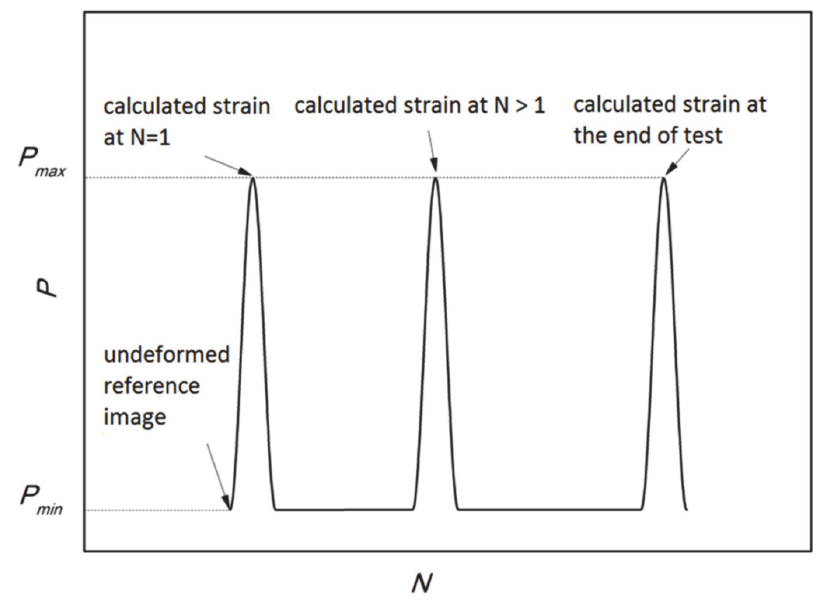
Figure 10: Illustration of the measurements performed to determine the strain around the welded